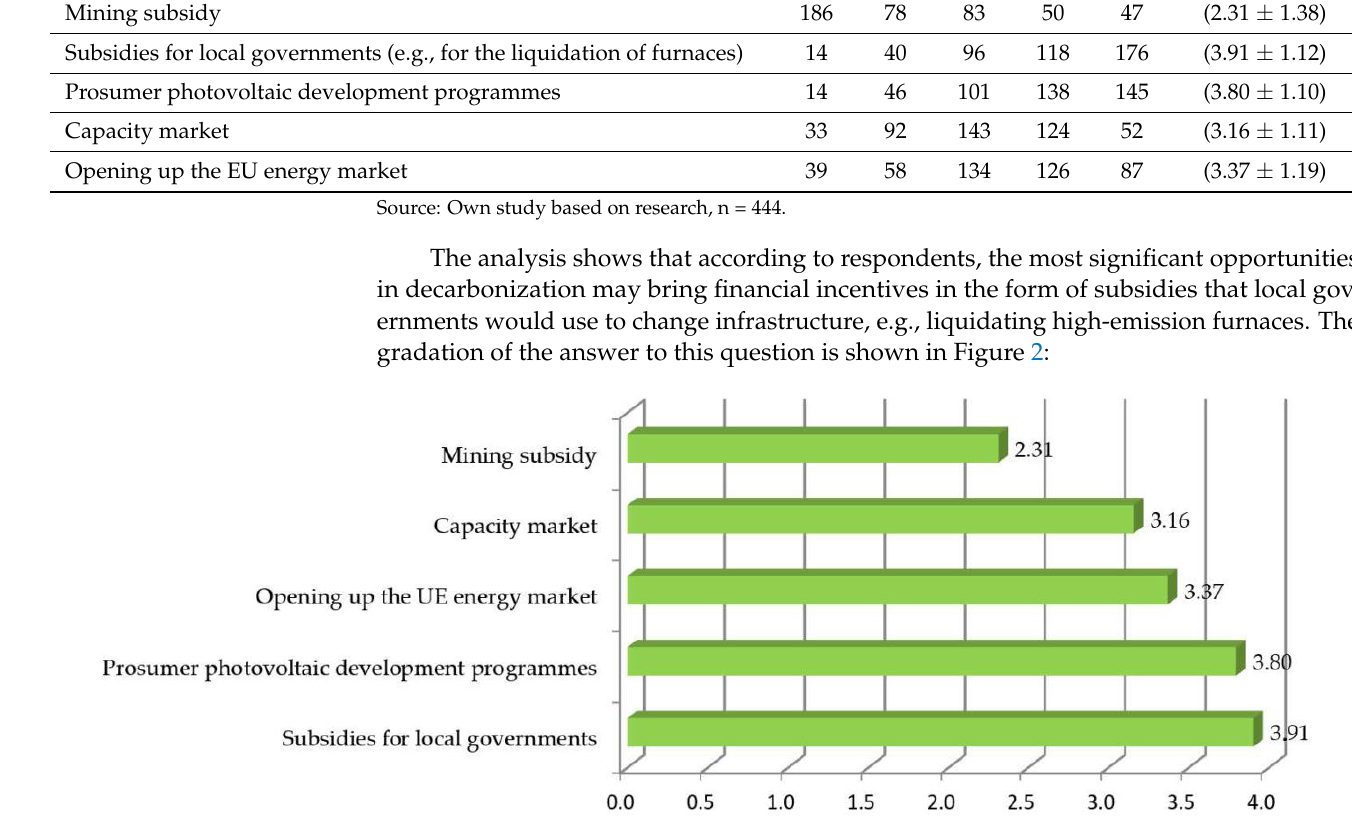
Figure 2. Activities affecting decarbonization — average assessments of individual factors. Source: Own study based on research, n = 444.